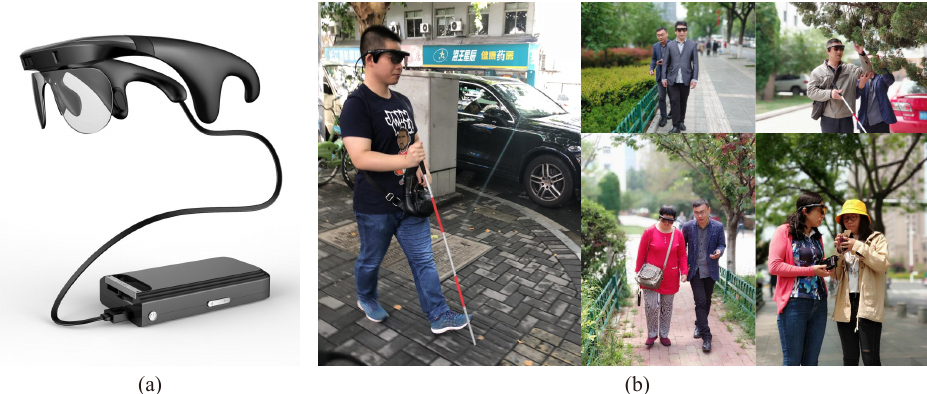
Figure 19. ( a ) Intoer: the wearable assistive devices for visually impaired people; and ( b ) visually impaired volunteers are wearing Intoer to capture images.